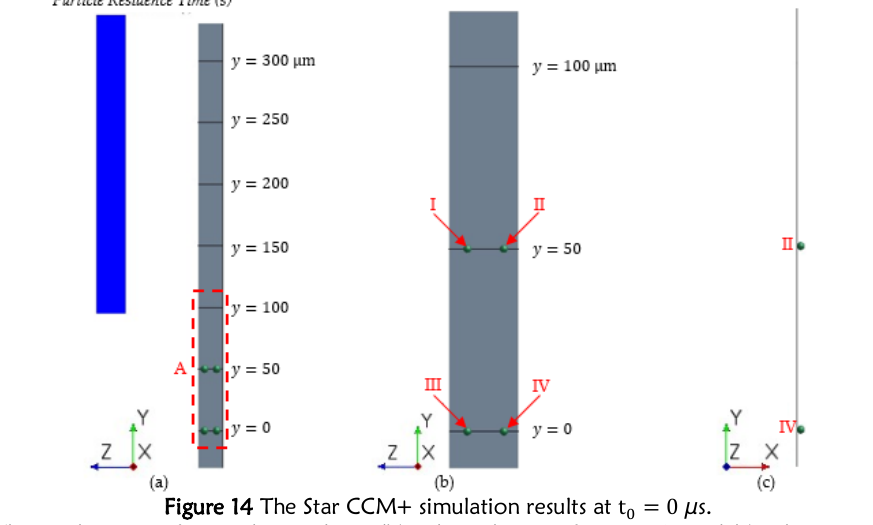
Figure 14 The Star CCM+ simulation results at t 0 = 0 µs.